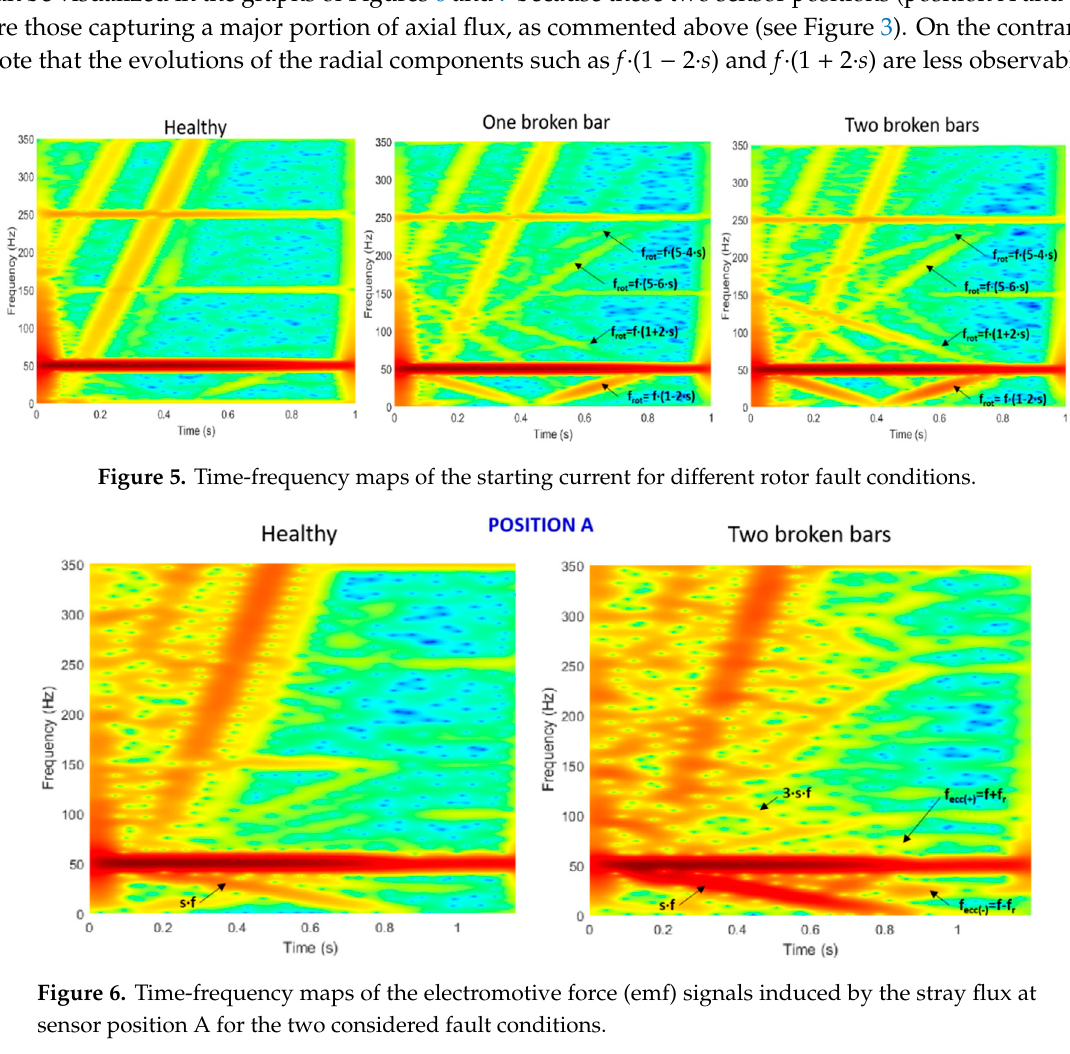
Figure 5. Time-frequency maps of the starting current for different rotor fault conditions.